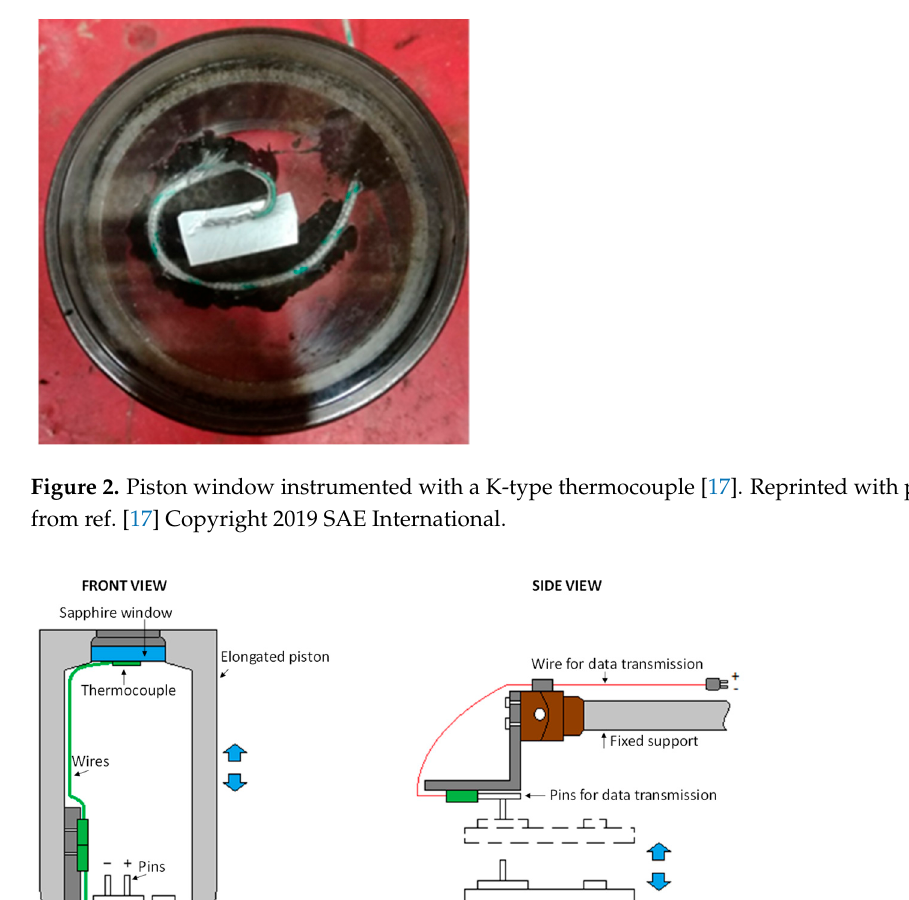
Figure 2. Piston window instrumented with a K-type thermocouple [17]. Reprinted with permis-